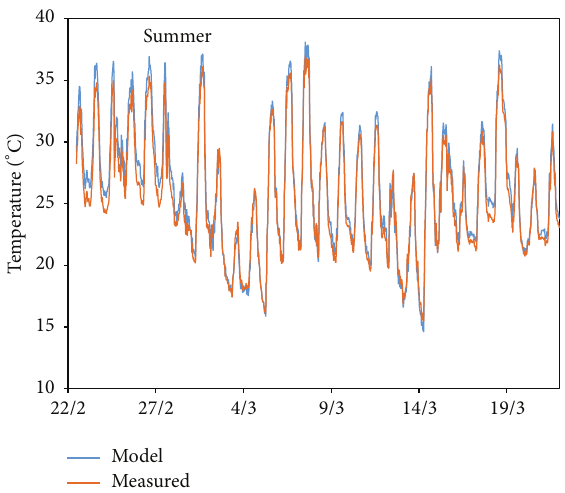
Figure 11: Summer comparison of the measured and the modeled temperatures.